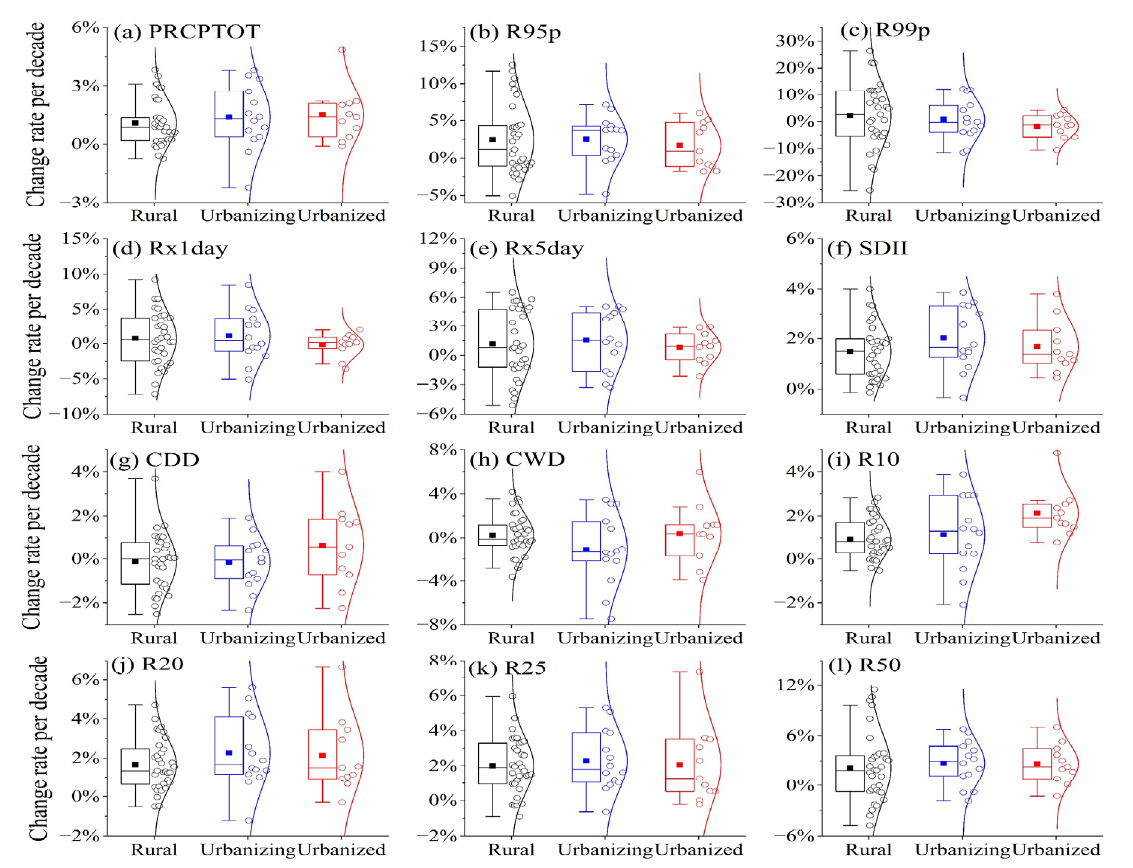
Figure 6. Boxplots of normalized trends (% per decade) in precipitation extremes for rural, urbanizing, and urbanized areas from 1961 to 2017. The solid squares represent the mean values in trends, and the lines in the box mean the 25%, 50%, and 75% values of normalized trends.